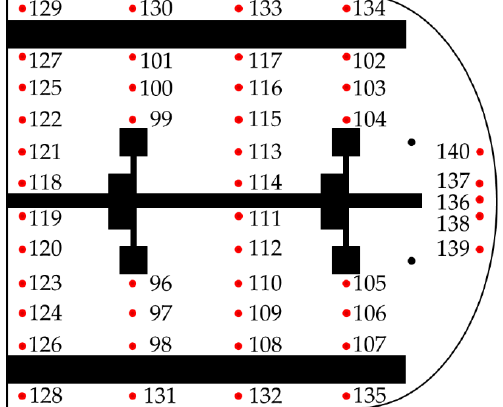
Figure A5. Map of the points used to monitor the velocity magnitude. The points were symmetrically distributed over a vertical plane, which crosses two baffles and cuts the reactor by half. Figure adapted from Sadino-Riquelme et al. [23].